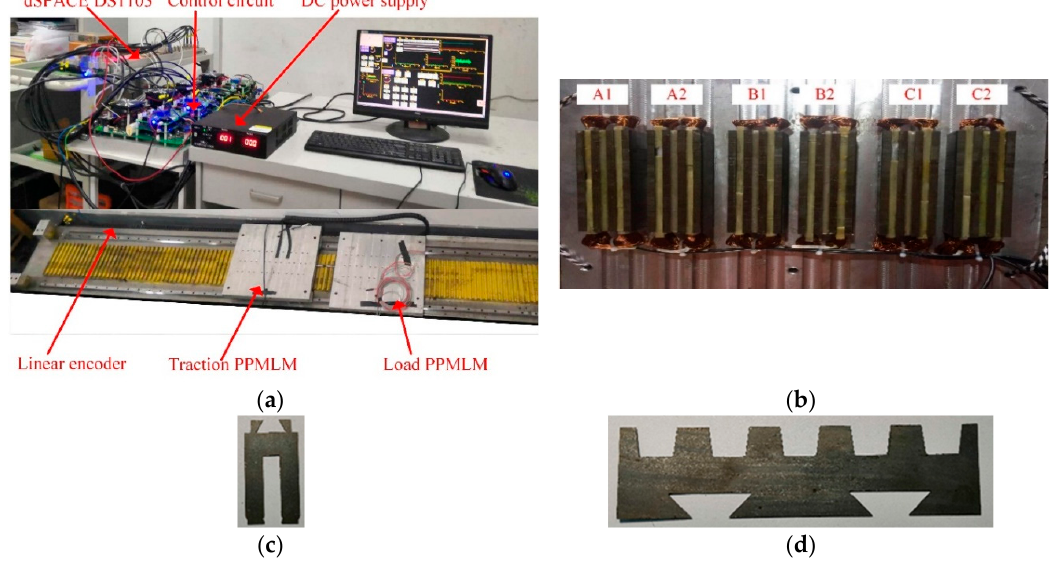
Figure 6. Test bench: ( a ) Entire view, ( b ) bottom view of mover, ( c ) stator teeth, and ( d ) stator teeth.